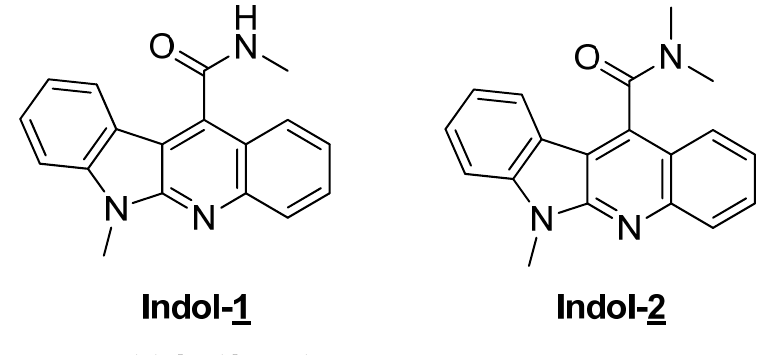
Figure 1. Indolo [2,3-b] quinolines.